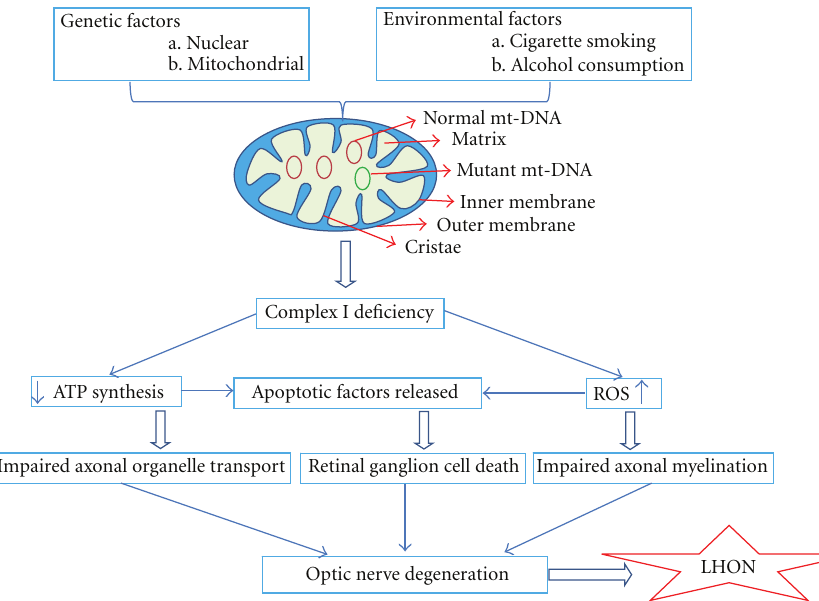
Figure 2: A schematic diagram illustrates the interaction of Complex I dysfunction, decreased ATP production, increased ROS, and apoptosis that culminate in the optic nerve degeneration of LHON and LHON cellular and animal models. ATP—adenosine triphosphate; ROS— reactive oxygen